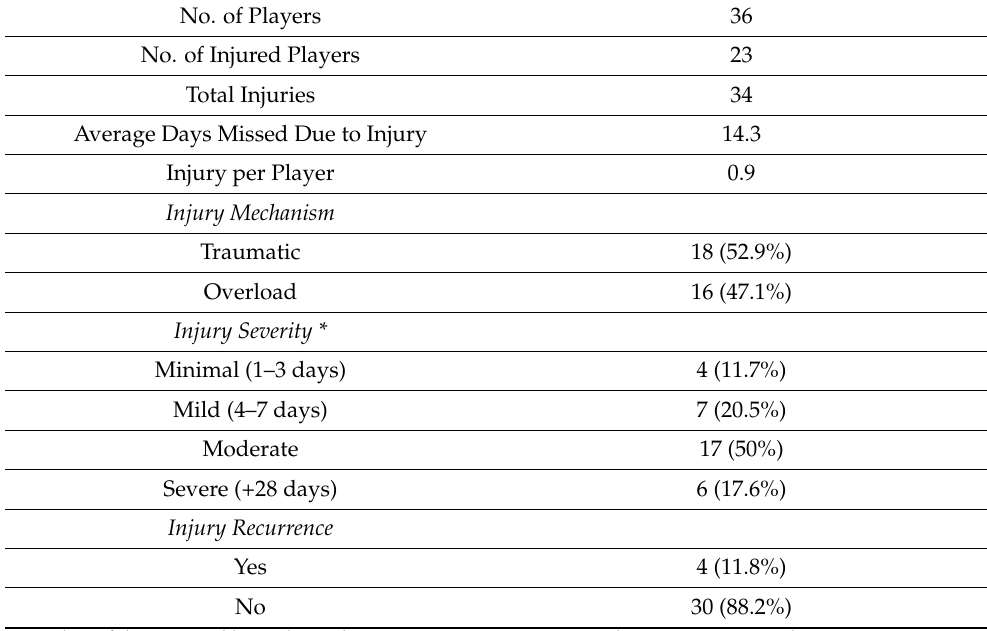
Table 2. Characterization of participants and injuries of CS Mar í timo in the 2020/2021 season. No. of